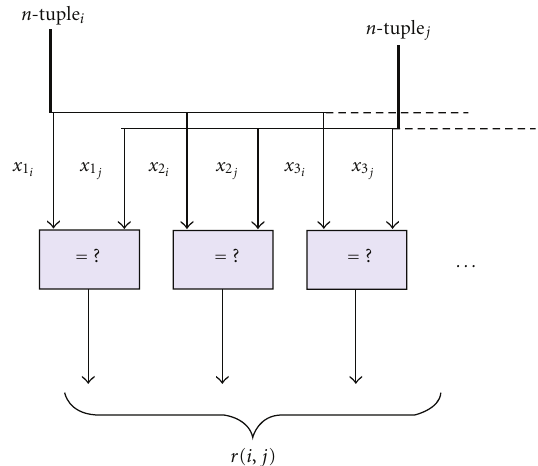
Figure 8: Computation of the disjunction of literals r ( i , j ) from a pair of n -tuples.